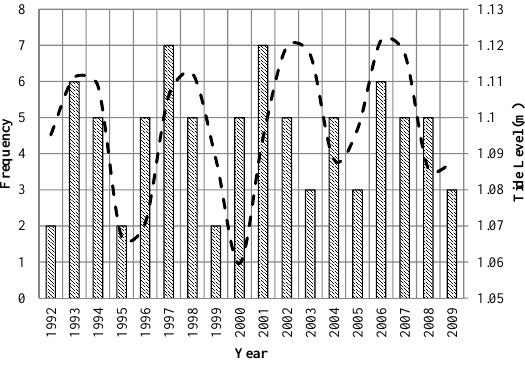
Fig. 7. Frequency of events exceeding 3.5 m shown by the column chart and simulated highest astronomical tides of each year relative to mean sea level shown by the dashed line.